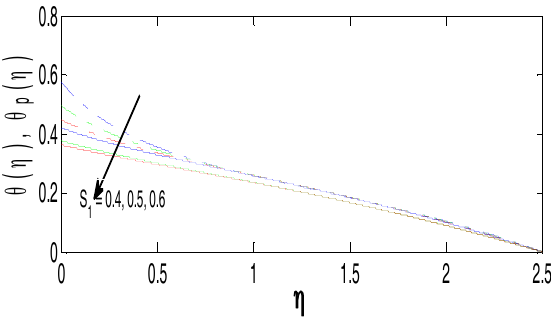
Figure 11. Impact of S 1 on temperature profile θ and θ p of fluid with dusty